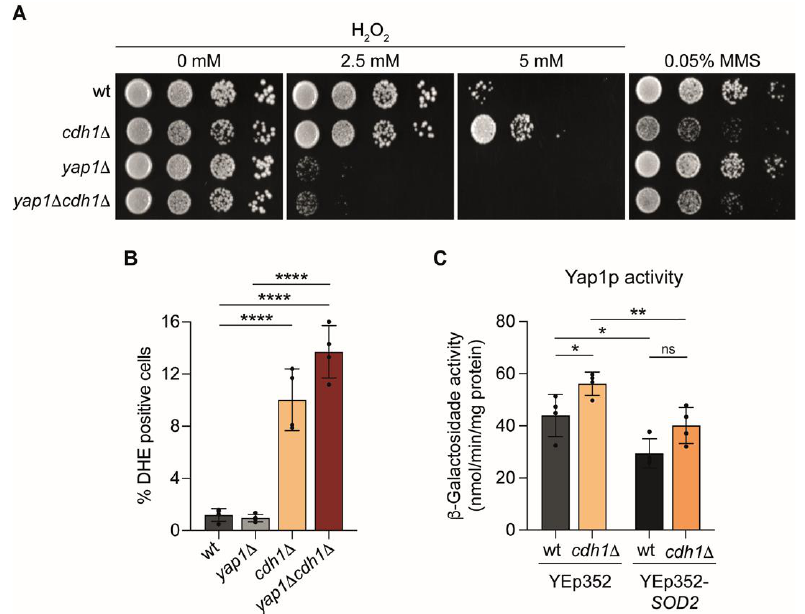
Figure 7. Yap1p mediates the oxidative stress resistance of the cdh1Δ strain. ( A ) H 2 O 2 and methyl methanesulfonate (MMS) sensitivity of wt, cdh1 Δ, yap1 Δ and yap1 Δ cdh1 Δ cells. Cells were grown until mid-log phase and ten-fold dilutions were spotted onto YPGal plates without a stressor or with 2.5–5 mM H 2 O 2 or 0.05% MMS. Plates were incubated at 26 °C for 2 days. A representative image is shown ( n = 3). ( B ) Cells with the indicated genotypes were grown until early-log phase and cellular ROS levels were assessed by flow cytometry using the fluorescent probe dihydroethidium (DHE). The values are the mean ± SD ( n = 4), ****, p < 0.0001; one-way ANOVA followed by Tukey’s multiple-comparison test. ( C ) Cells with the indicated genotypes harboring pRS415-AP-1-CYC1-LacZ reporter were grown to mid-log